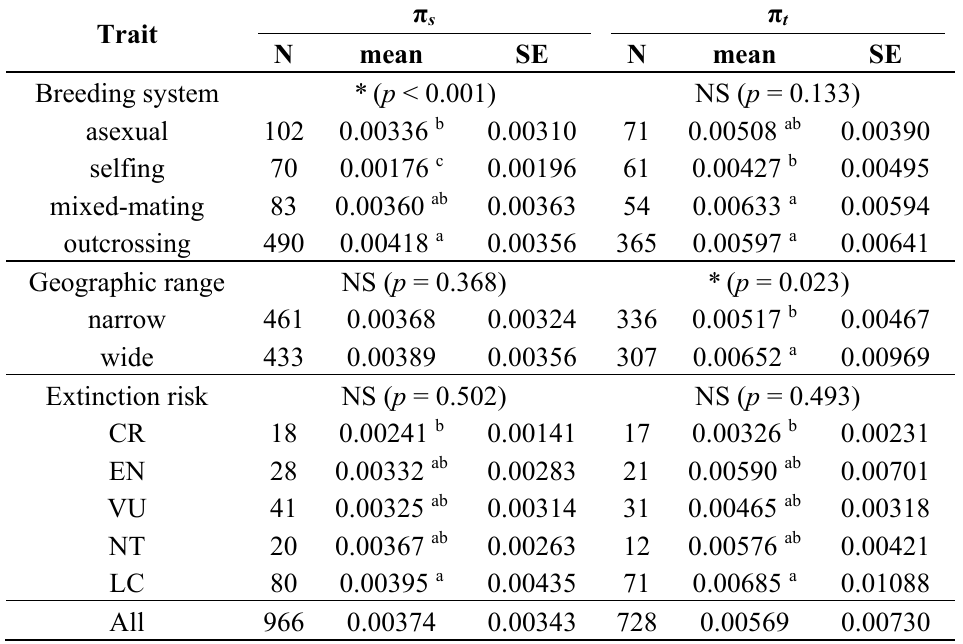
Table 3. Summary of the population-level ( π s ) and species-level ( π t ) nucleotide diversity of the sampled taxa grouped by different